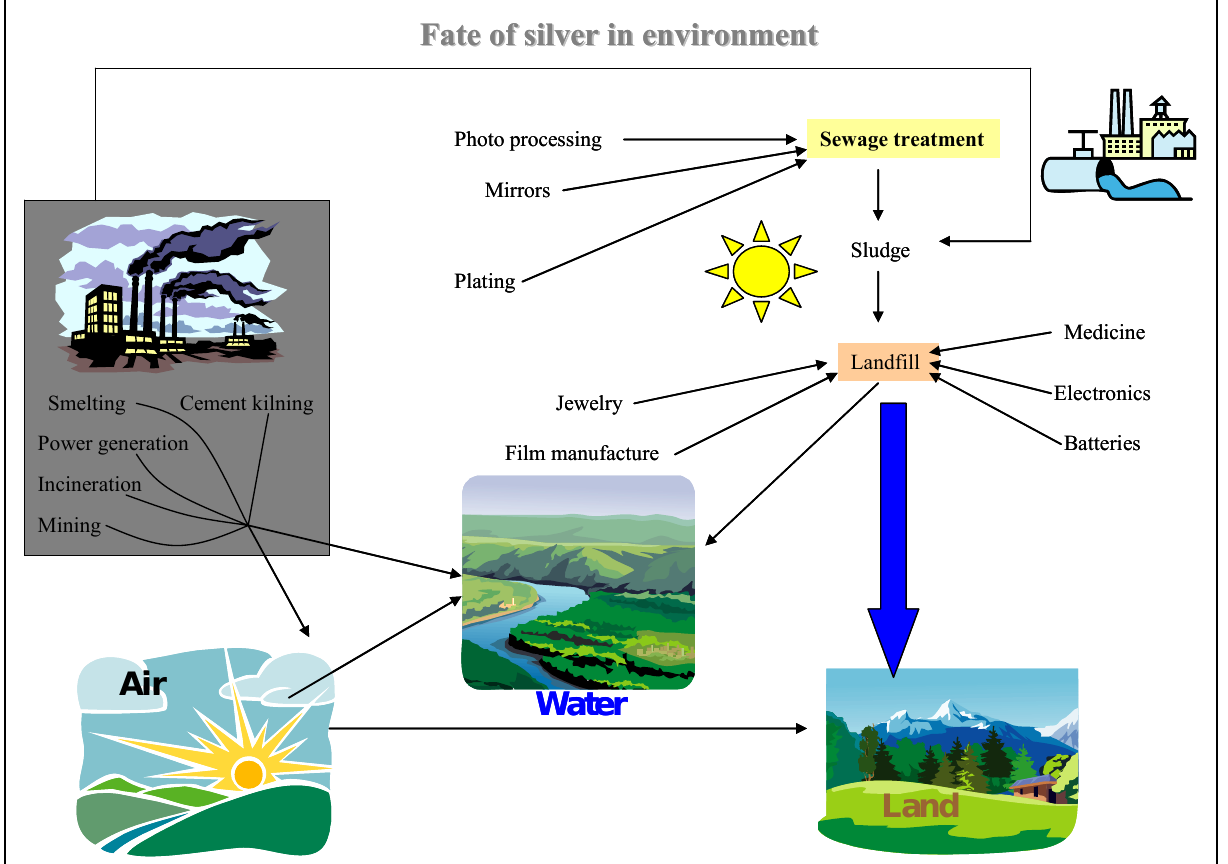
Figure 1. Scheme of silver(I) ion fate in the